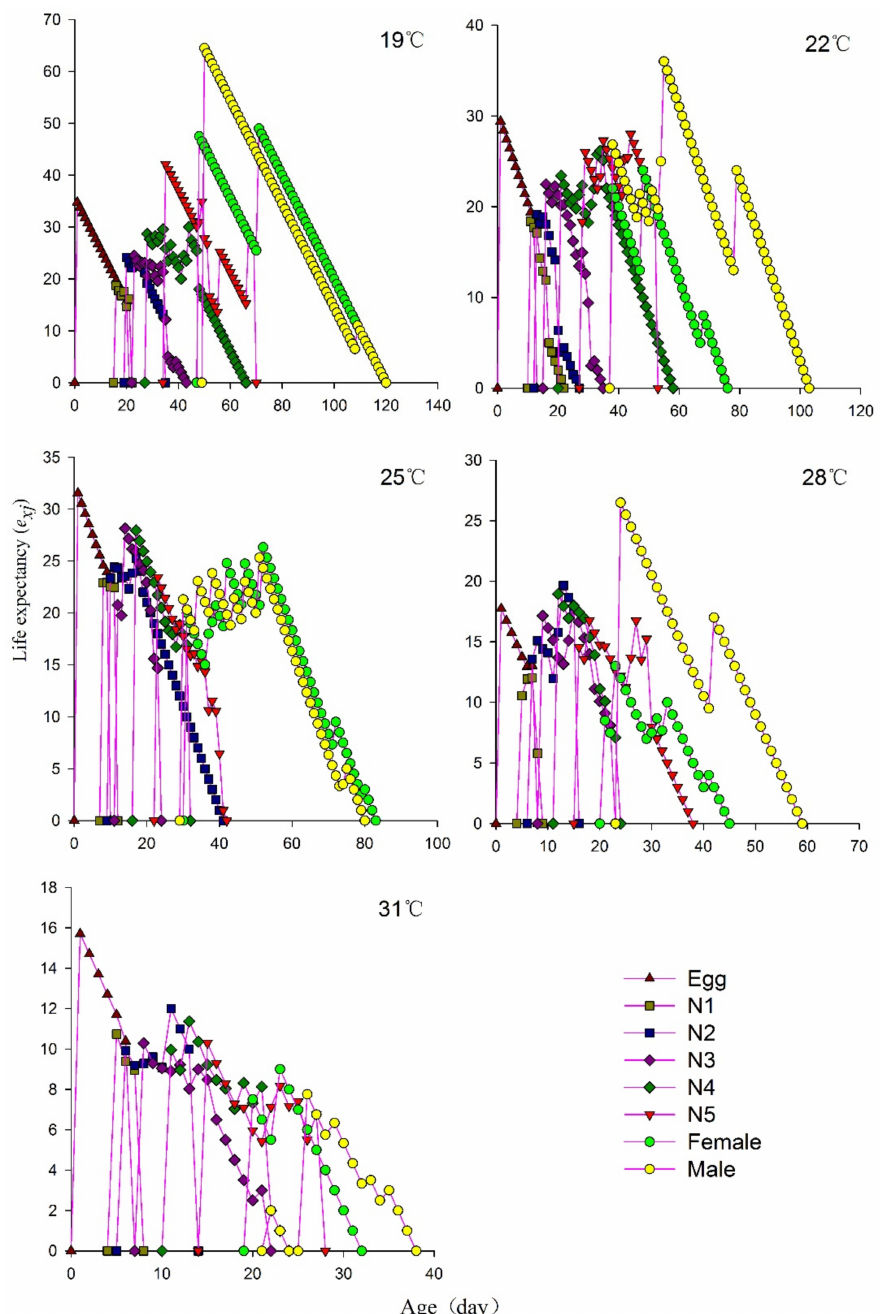
Figure 4. Life expectancy ( e xj ) of each age–stage group of Riptortus pedestris at different temperatures. Note: N1–N5 represents first, second, third, fourth, and fifth instar,